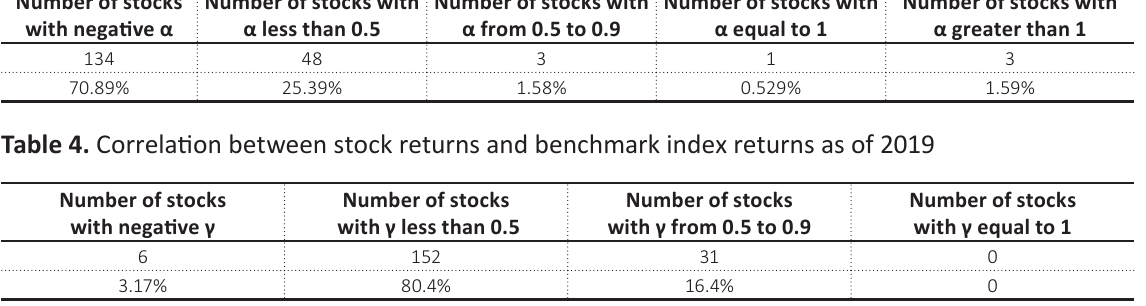
Table 3. Alpha ( α ) value of stocks listed in Tadawul as of 2019 Number of stocks Number of stocks with with negative α α less than 0.5